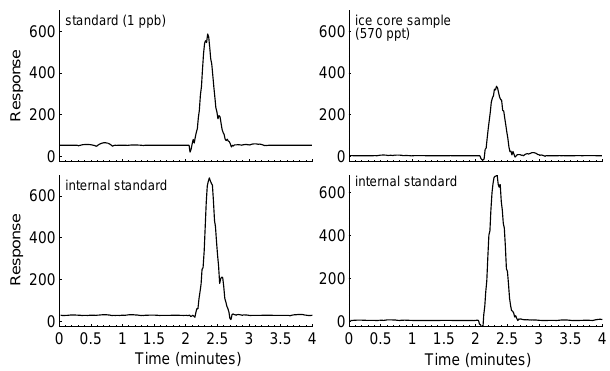
Figure 3. Vanillic acid chromatograms. Left: 1 ppb vanillic acid standard in Milli-Q water ( 12 C, 167 → 108 m/z ) (upper) with 1 ppbinternal standard ( 13 C-labeled vanillic acid, 168 → 108 m/z ) (lower). Right: Akademii Nauk ice core sample containing 570ppt vanillic acid (325m depth, AD 286) ( 12 C, 167 → 108 m/z ) (up- per) with 1ppb internal standard ( 13 C-labeled vanillic acid, 168 → 108 m/z )